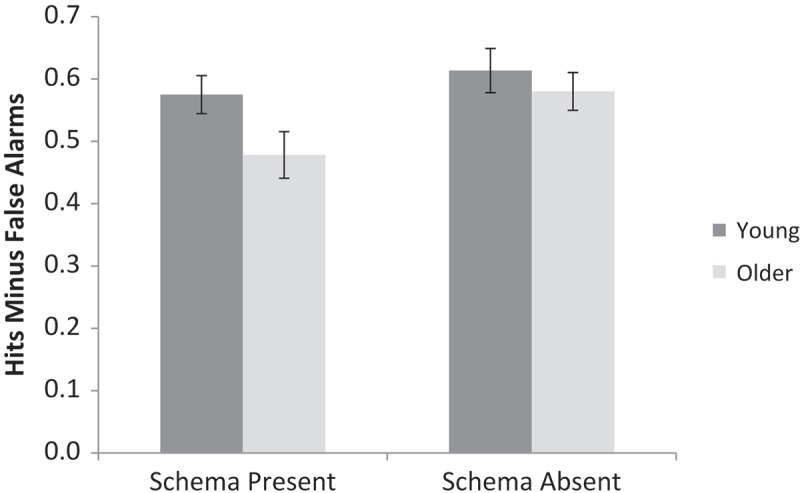
Proportion of hits minus proportion of false alarms for schema-present and schema-absent conditions for young and older adults in Experiment 3. Error bars are ± 1SE.